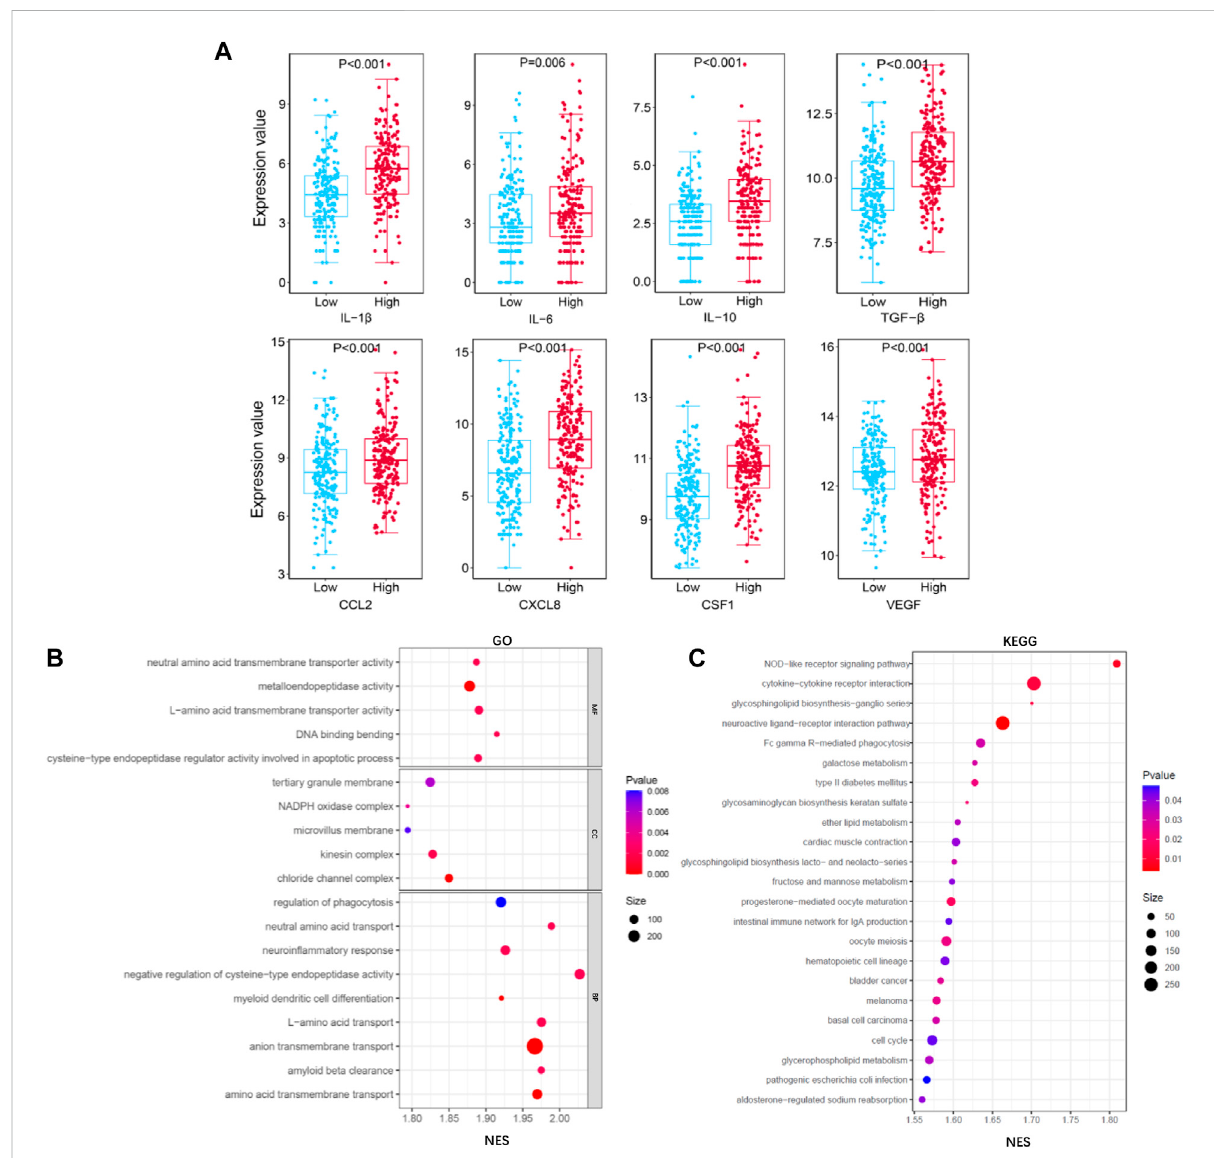
FIGURE 9 Functional analysis for TIMGs. (A) Comparison of the expression value of cytokines (IL-1 β , IL-6, IL-10, TGF- β , CCL2, CXCL8, CSF-1, and VEGF) with different groups of TIMSig in the TCGA cohort. (B) GO function analysis of TIMSig in the TCGA cohort. (C) KEGG pathway analysis of TIMSig in the TCGA